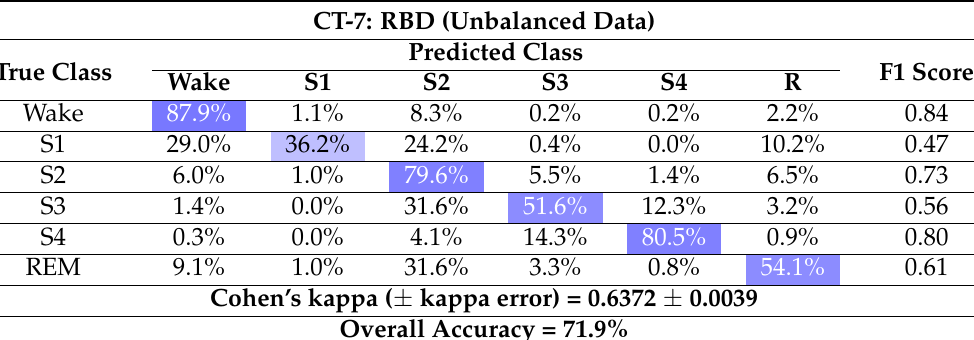
Table 21. Confusion matrix corresponding to sleep stage classification of REM behavioural disorder patients with unbalanced data using the EBT classifier with 10-fold